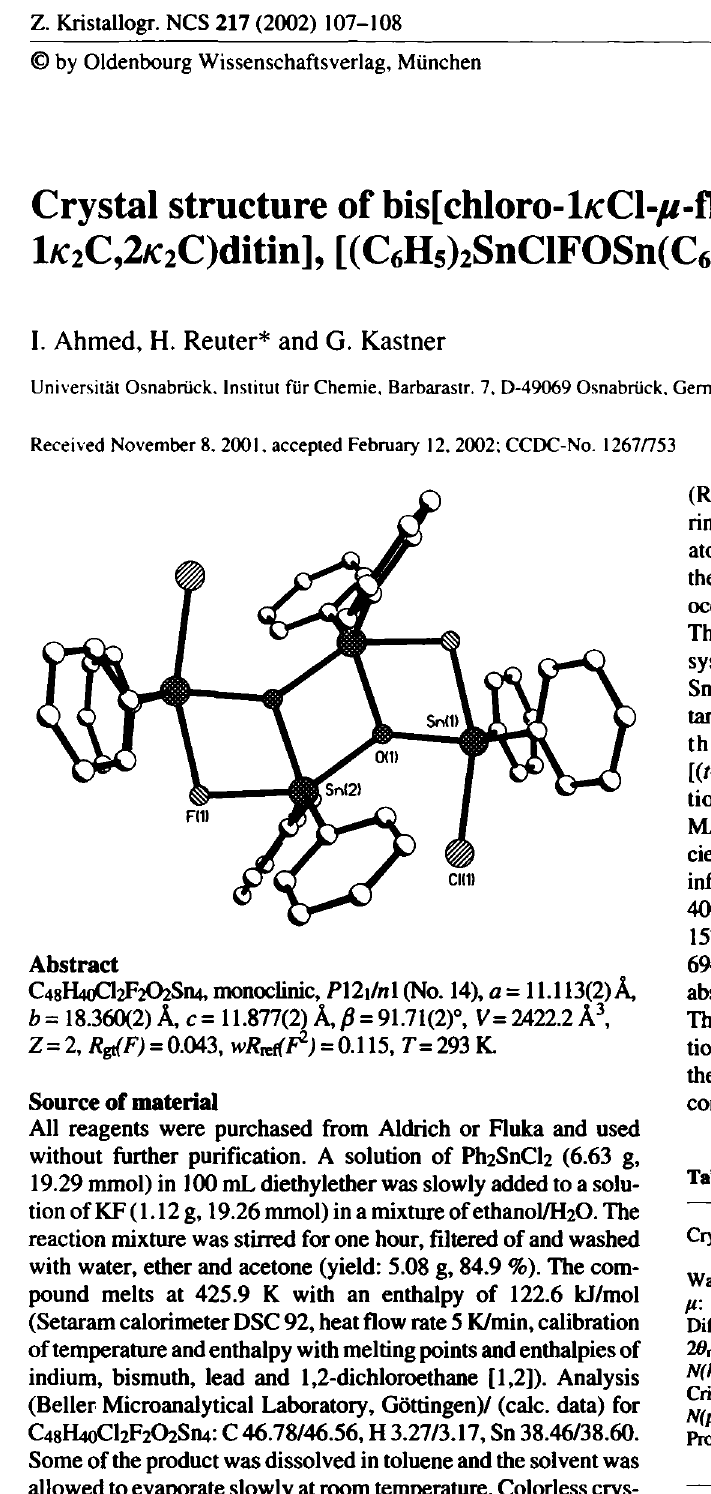
Table 2. Atomic coordinates and displacement parameters (in Â 2